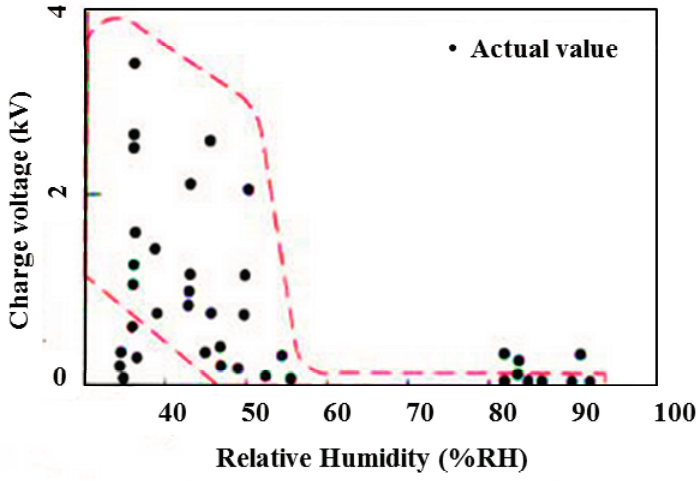
Figure 2. Relationship between humidity and static electricity (with permission from